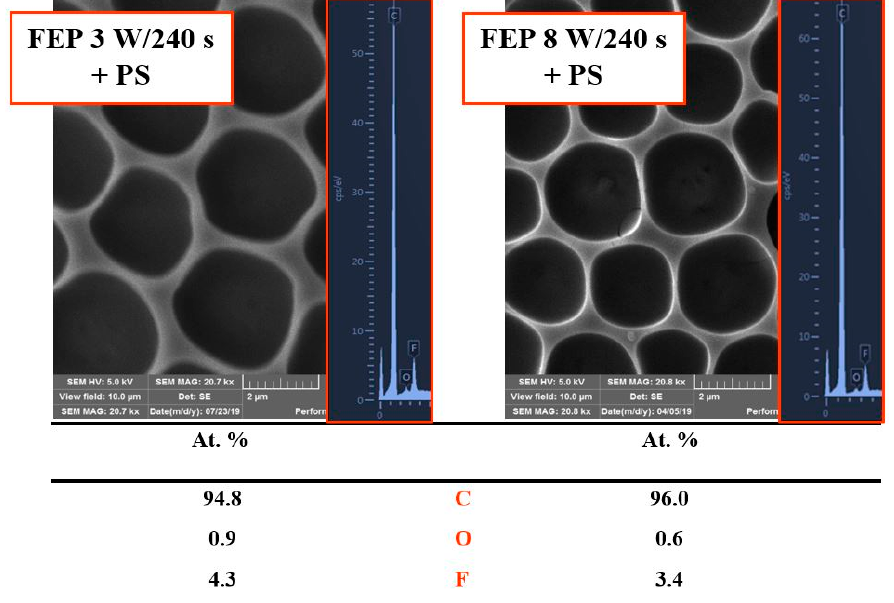
Figure 5. Scanning electron microscopy images (10 × 10 µ m 2 ) of plasma-modified fluorinated ethylene propylene (FEP) treated at different plasma discharges (3 and 8 W) with a polystyrene (PS) layer forming a honeycomb-like pattern. On the right side, corresponding energy-dispersive X-ray spectroscopy graphs and a table of element concentration on the surface are depicted.